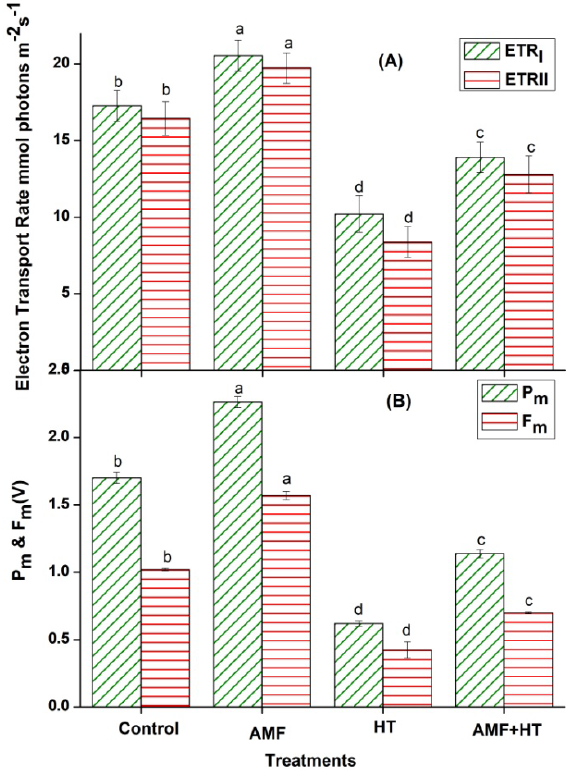
Figure 2. Response of ( A ) electron transport rates in PSI (ETR I ) and PSII (ETR II ), ( B ) maximal change in P700 (Pm) and maximum fluorescence (F m ) signal, assessed in maize leaves. The data are the mean values of three replicates ± standard deviation, treatment means followed with different letters vary significantly at p = 0.05 in compliance with Fisher least significant differences (LSD) and Duncan multiple range test (DMRT) for multiple comparisons.